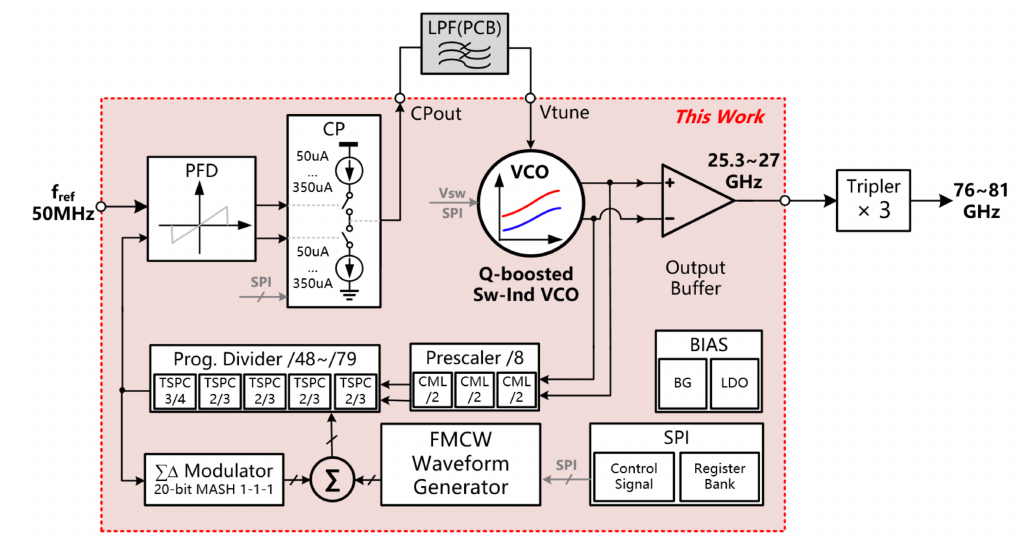
Figure 1. Block diagram of the K-band frequency synthesizer for 77 GHz frequency-modulated continuous-wave (FMCW) radar